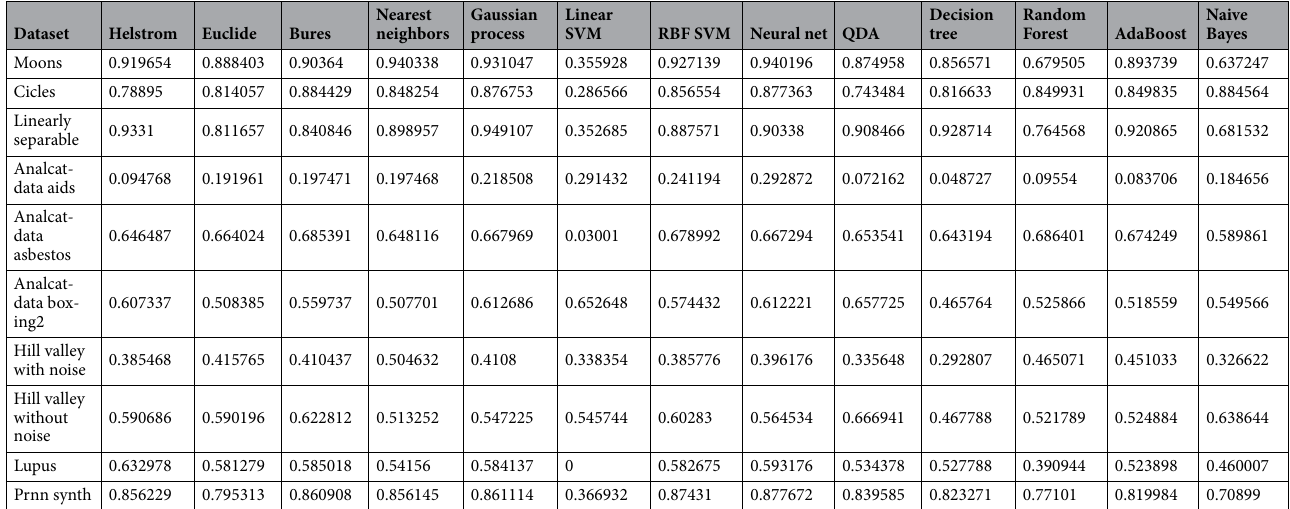
Table 7. F 1-score with 2 features mapped into high-dimensional feature space ℝ 122 .